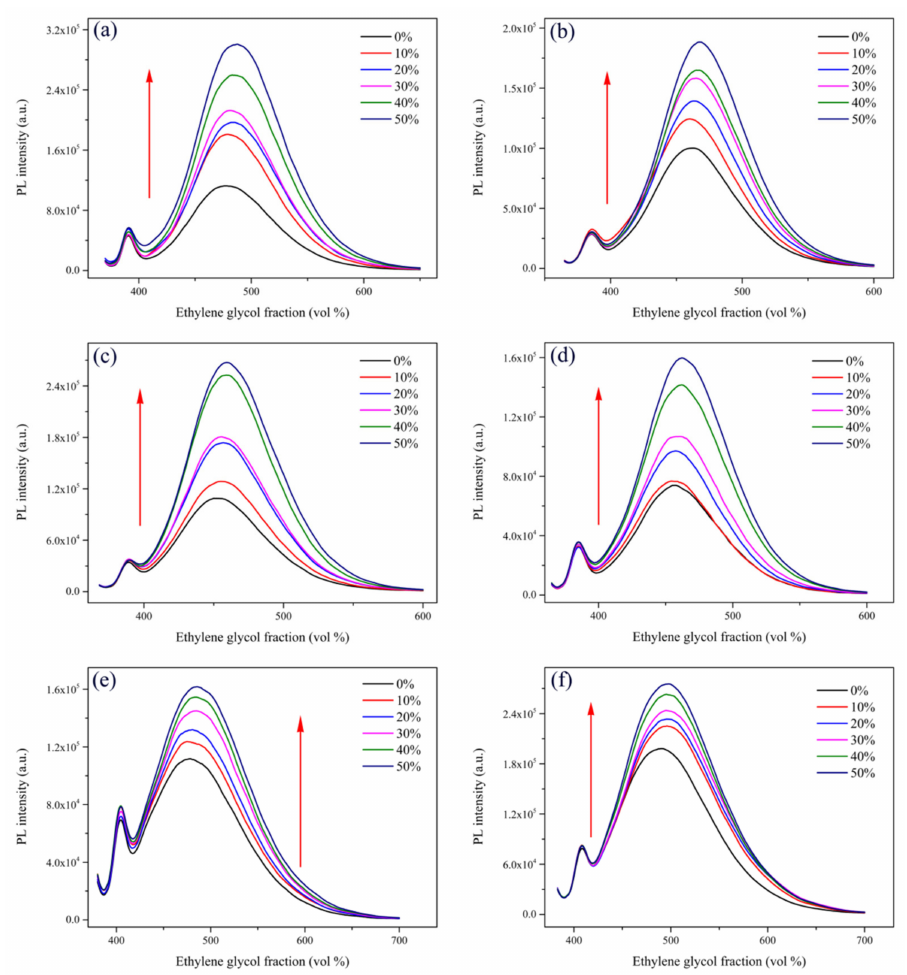
Figure 6. Fluorescence intensity of compounds ( a ) 1 , ( b ) 2 , ( c ) 3 , ( d ) 4 , ( e ) 5 , and ( f ) 6 in CH 3 OH/EG mixed solutions with different EG fractions